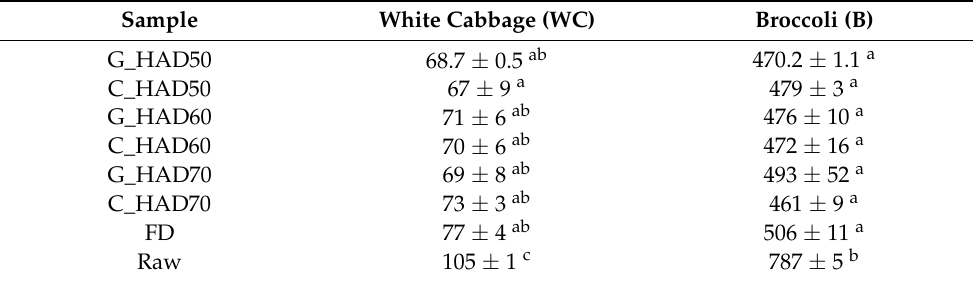
Table 6. Sulforaphane content ( µ g/g dm ) of powders and raw samples. WC: white cabbage, B: broccoli; G: ground, C: chopped; HAD: hot-air drying at 50, 60 and 70 ◦ C, FD: freeze drying. Mean ± standard